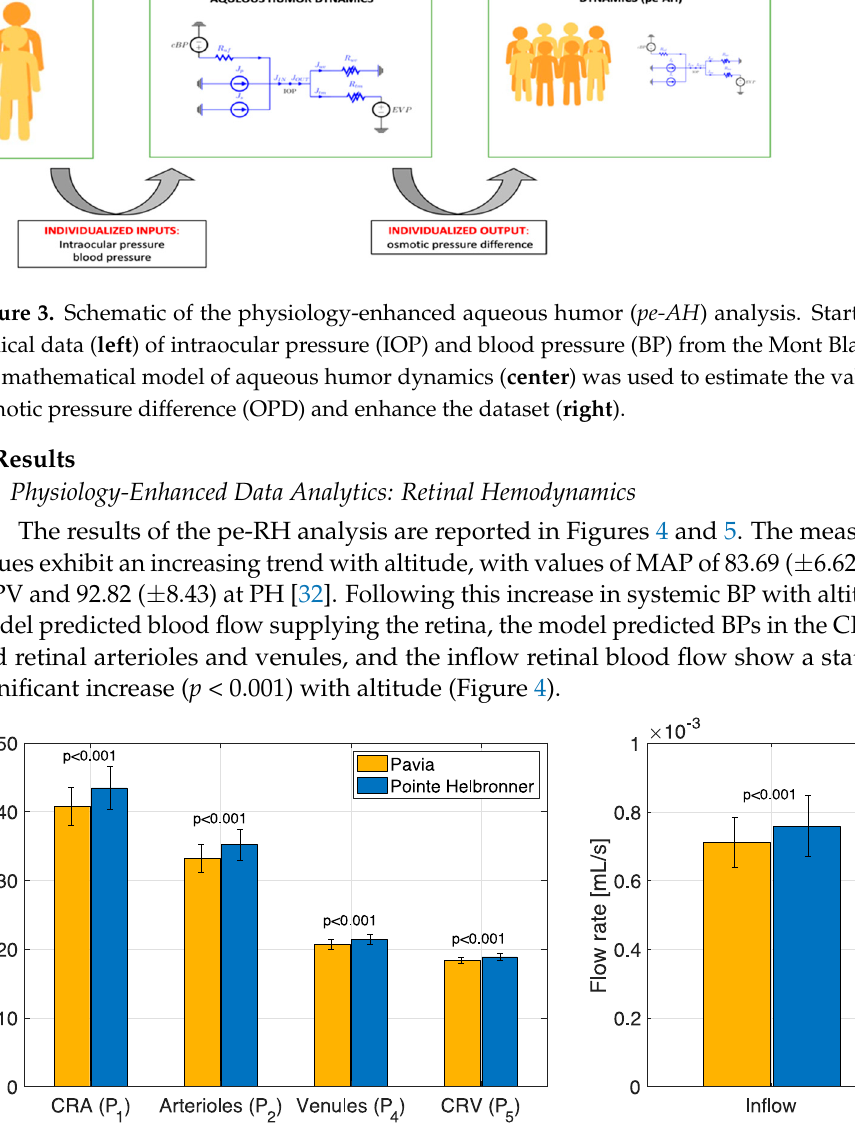
Figure 4. The physiology − enhanced retinal hemodynamics analysis predicted average values and standard deviation of the vascular pressures and blood flow rates in different retinal vascular beds for the two locations/altitudes considered. CRA: central retinal artery; CRV: central retinal vein. At- tribution: Carichino L.; Guidoboni G.; Szopos M.; Verticchio Vercellin A.C.; Bruttini C.; Riva, I.;